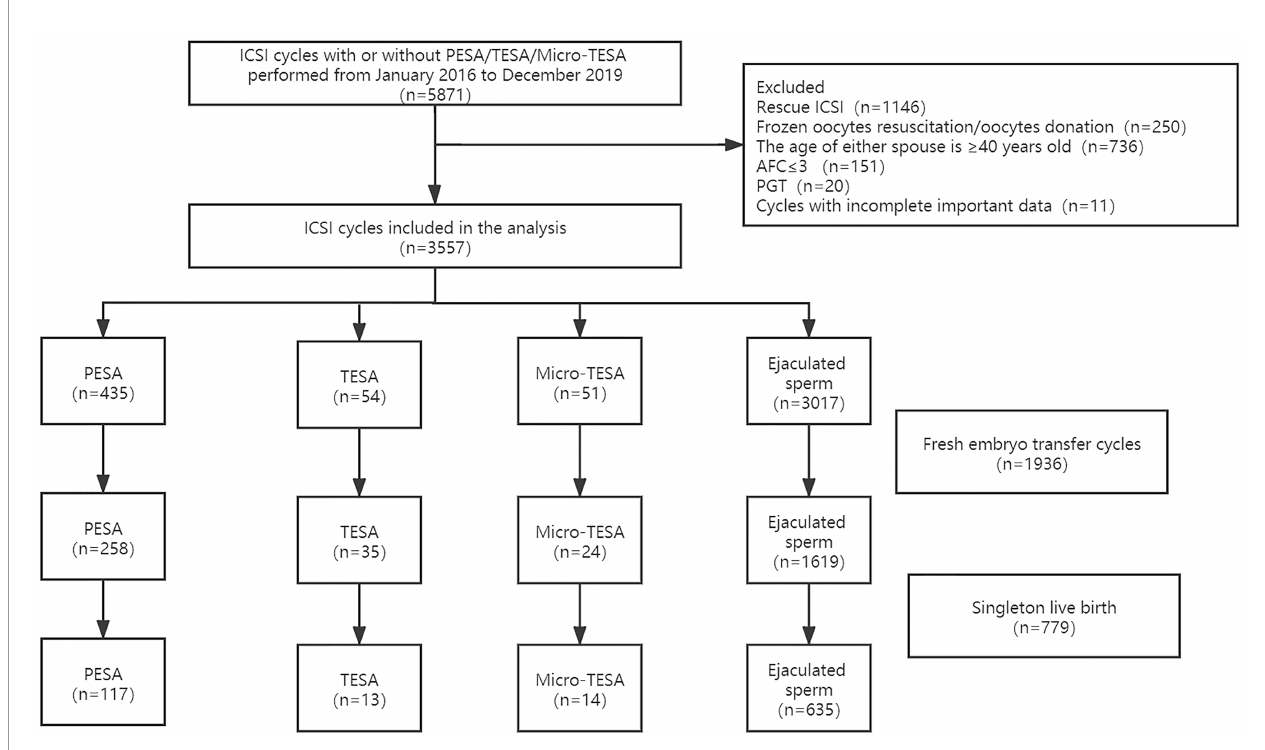
FIGURE 1 | Flow chart of the study